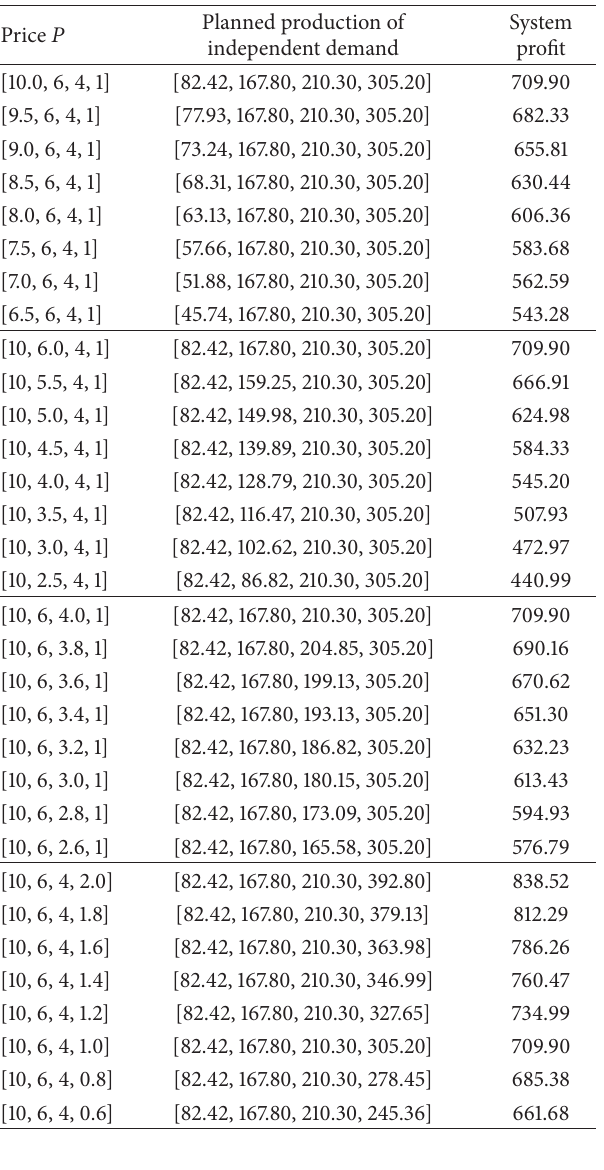
Table 2: Planned production of independent demand and system profit sensitivity analysis to price 𝑃